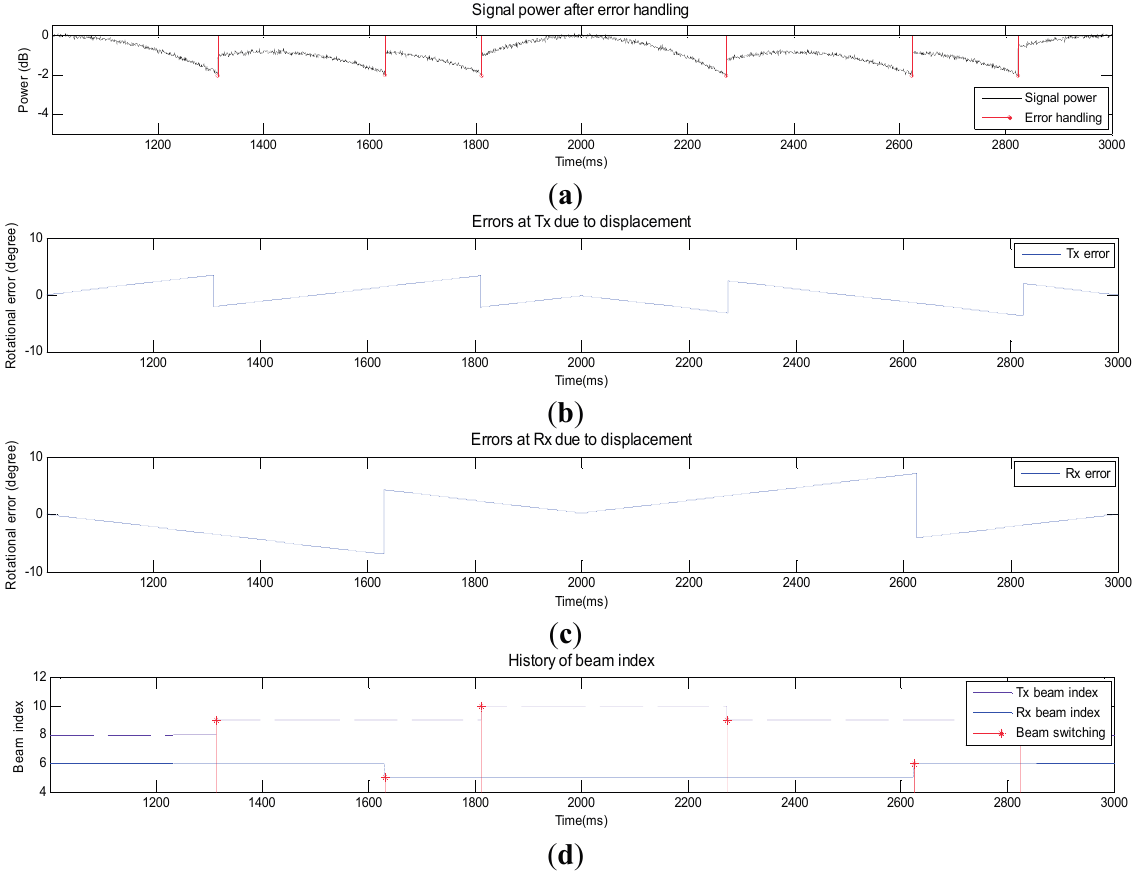
Figure 7. Performance of the proposed beam-tracking technique in Scenario 2.